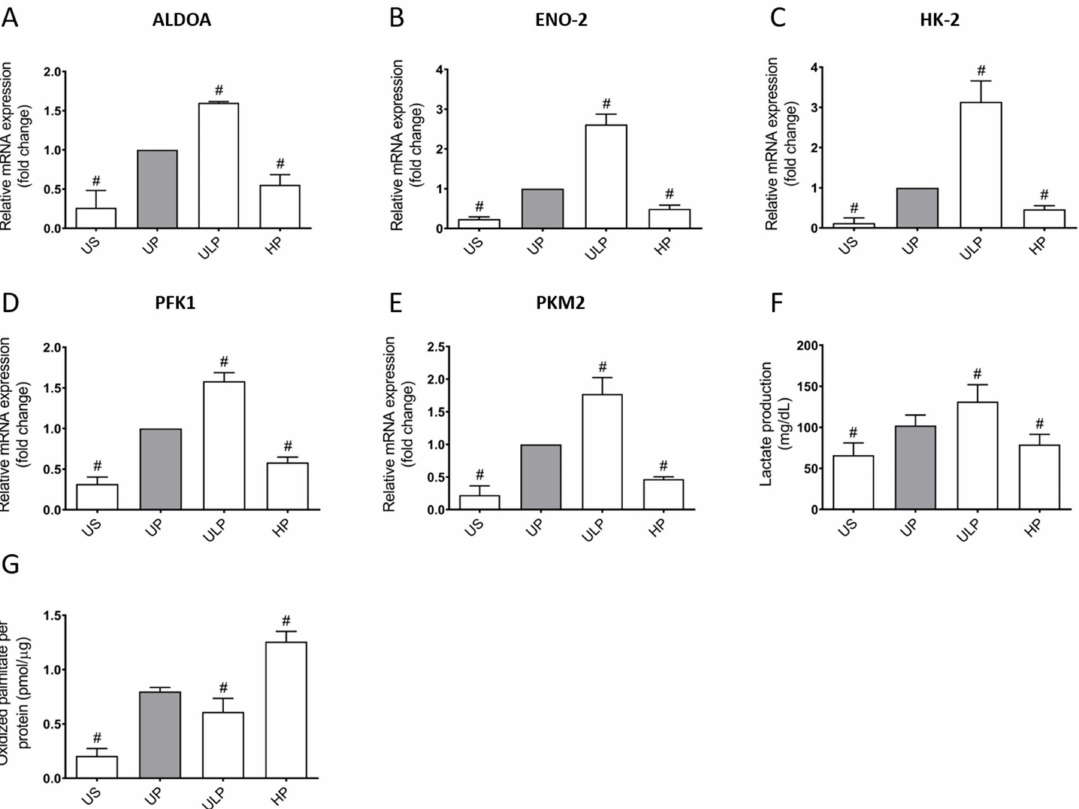
Figure 2. Aerobic glycolysis and β -oxidation of fatty acids support opposing memory-like inflammatory responses in LPS-primed microglia. Primary microglial cells were analyzed for gene expression of ( A ) aldolase A (ALDOA), ( B ) enolase 2 (ENO-2), ( C ) hexokinase 2 (HK-2), ( D ) phosphofructokinase 1 (PFK1), ( E ) pyruvate kinase M2 (PKM2) (n = 4; real-time PCR, normalized to glyceraldehyde-3-phosphate dehydrogenase (GAPDH) at unprimed state). ( F ) Lactate production (n = 7) and ( G ) fatty acid oxidation were measured (n = 3; normalized to protein concentration). Microglia isolated from newborn mice were primed initially by ultra-low (ULP, 1 fg/mL) or high (HP, 100 ng/mL) doses of LPS, followed by a second stimulation (day 6) with 100 ng/mL LPS. Data were compared to unprimed microglia (UP group without any stimulation at day 1 with stimulation at day 6 with a fixed dose of LPS, 100 ng/mL). Unstimulated microglia (US) served as the negative control. Data are presented as means + SD, # p < 0.05 vs. unprimed conditions (UP, grey